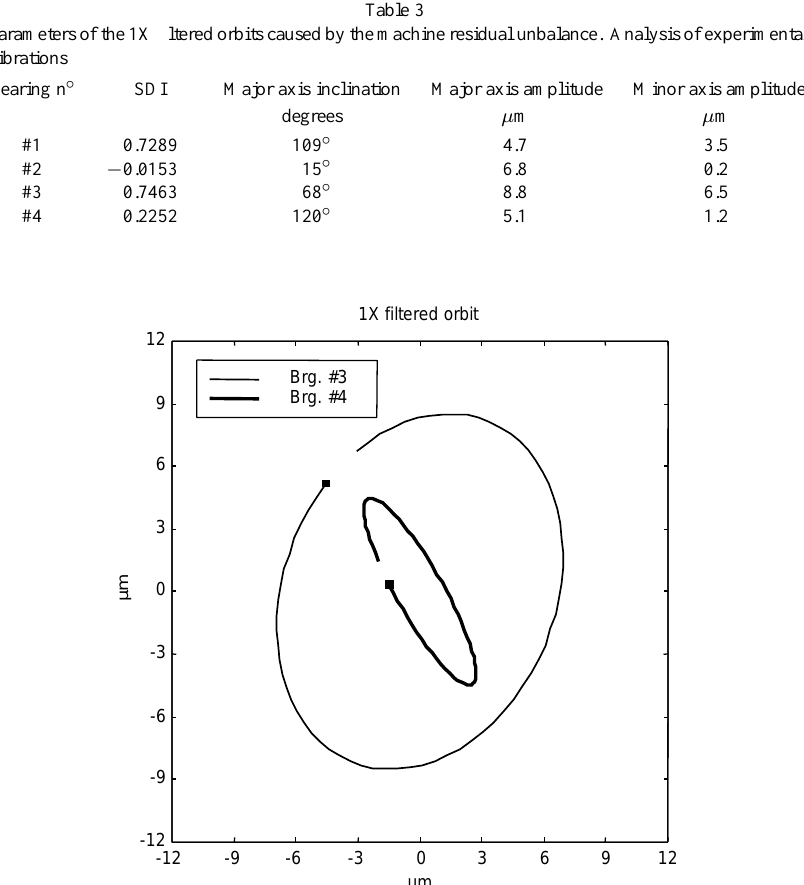
Fig. 7. 1X filtered orbit induced by the residual unbalance of the machine on bearings #3 (gererator) and #4 (gearbox). Experimental data.